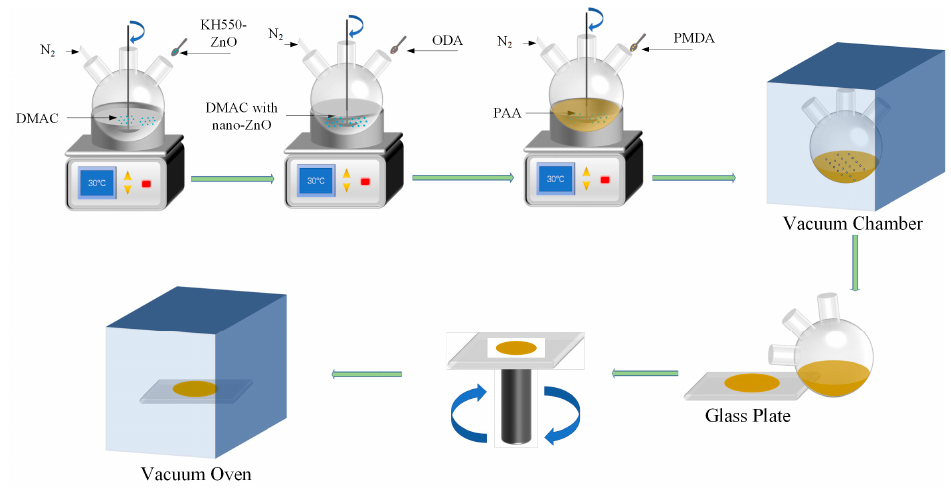
Figure 1. Preparation process of the nano-ZnO/PI film sample.